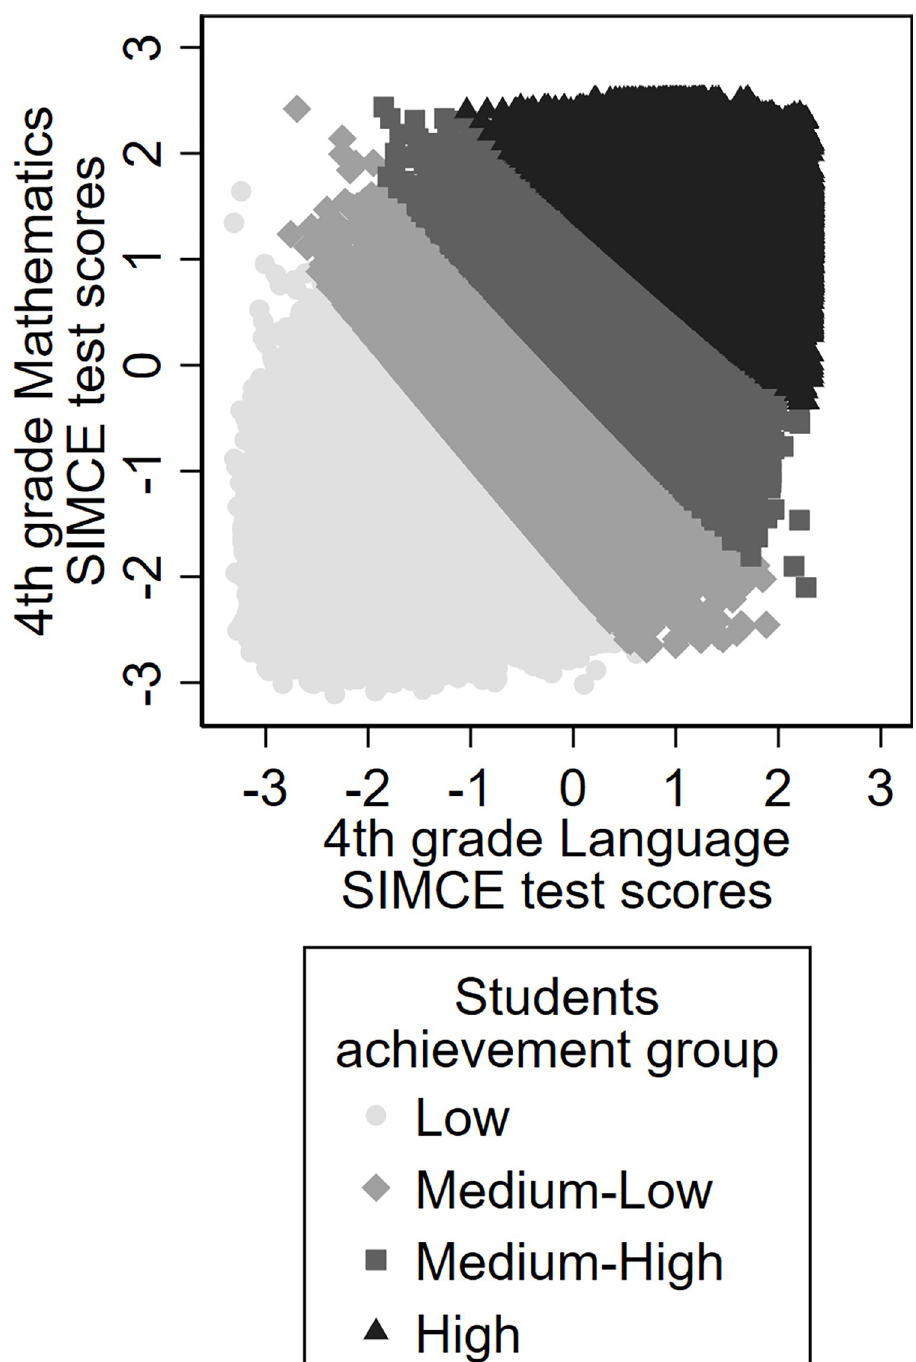
Fig 1. Student’s achievement groups. Each dot represents a student according to their 4 th grade Language SIMCE (x- axis) and Mathematics (y-axis) score. Both scores are measured in units of standard deviation. The students were classified into groups according to both scores, using the k-means methodology with Euclidean distance; the dot color shows the group each student is in.